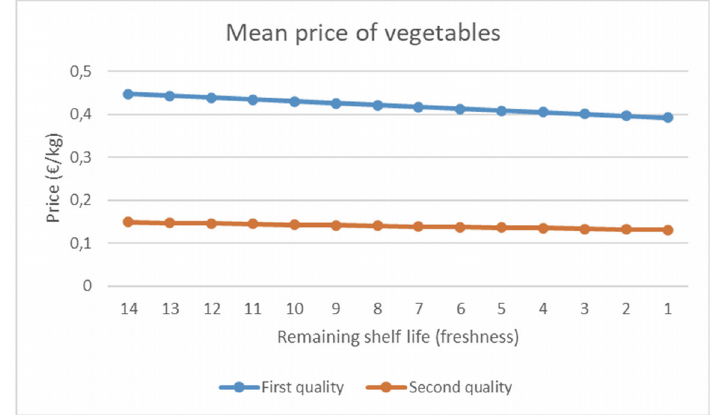
Figure 2. Mean price of vegetables according to freshness and quality